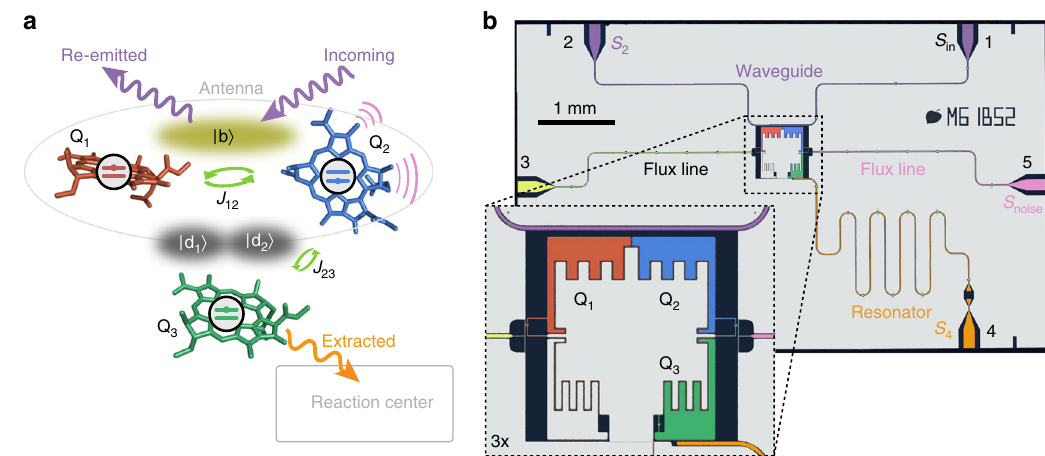
Fig. 1 Model system for light harvesting and its superconducting circuit realization. a Schematic of three coupled chlorophyll molecules hosting chromophores modeled as three qubits Q 1,2,3 (red, blue, and green). The strongly coupled Q 1 and Q 2 hybridize with coupling strength J 12 into a bright state | b 〉 (olive cloud) and dark states (dark gray clouds). Q 2 is coupled to Q 3 with a coupling strength J 23 which forms the dark hybridized states |d 1 〉 and |d 2 〉 . The incident, the re-emitted, and the harvested radiation are indicated by arrows. Pink lines indicate that Q 2 is subjected to environmental noise. b False color micrograph of the superconducting circuit. Transmon qubits Q 1 and Q 2 (red, blue) are capacitively coupled to a transmission line (purple) and Q 3 (green) is capacitively coupled to a high-emission-rate resonator (orange). Excitation radiation ( S in ) is applied through port 1 of the transmission line. The re-emitted ( S 2 ) and extracted radiation ( S 4 ) are detected at port 2 and 4, respectively. Low-frequency noise with an engineered spectral density, modeling the environment ( S noise ), is applied to Q 2 via the fl ux line at port